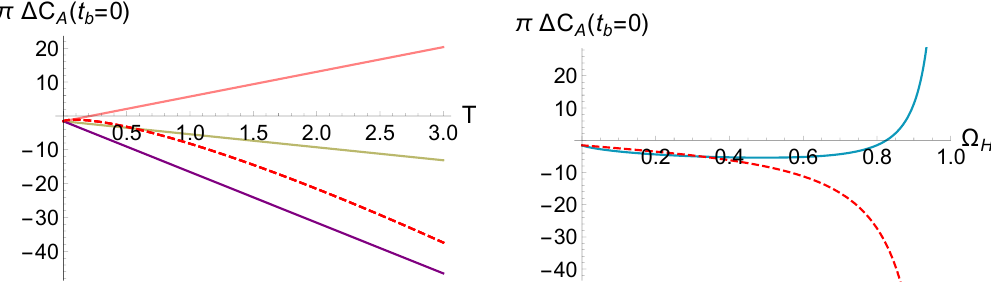
Figure 7 . The plots illustrate the dependence on the counteterterm and its scale of the complexity of formation π ∆ C A ( t b = 0) for ‘ = G N = 1 . (Left) Ω H = 0 . 5 and in solid lines, L ct = 0 . 1 , 1 , 10 increasing from the top down, (right) T = 1 . In red dashed in both plots, the complexity of formation without the